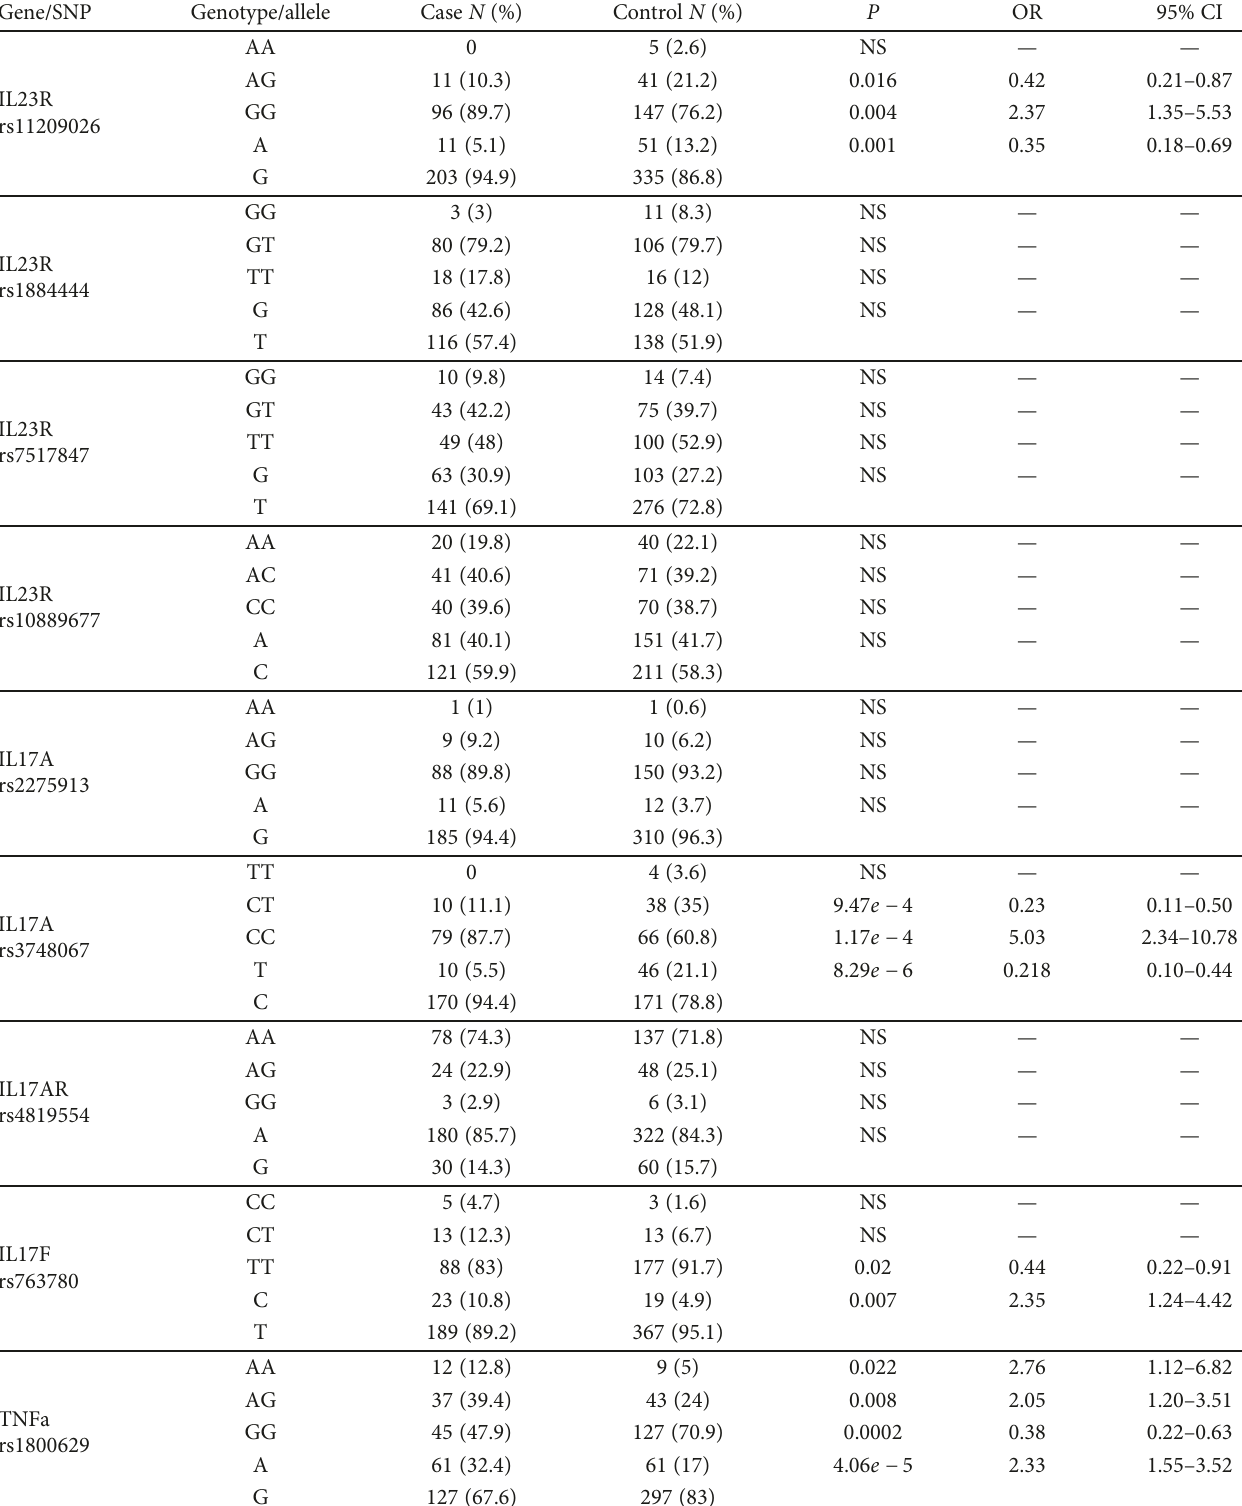
Table 3: Genotype and allele frequencies of IL23/Th17 pathway ’ s genes polymorphisms in Pemphigus foliaceus patients and matched healthy